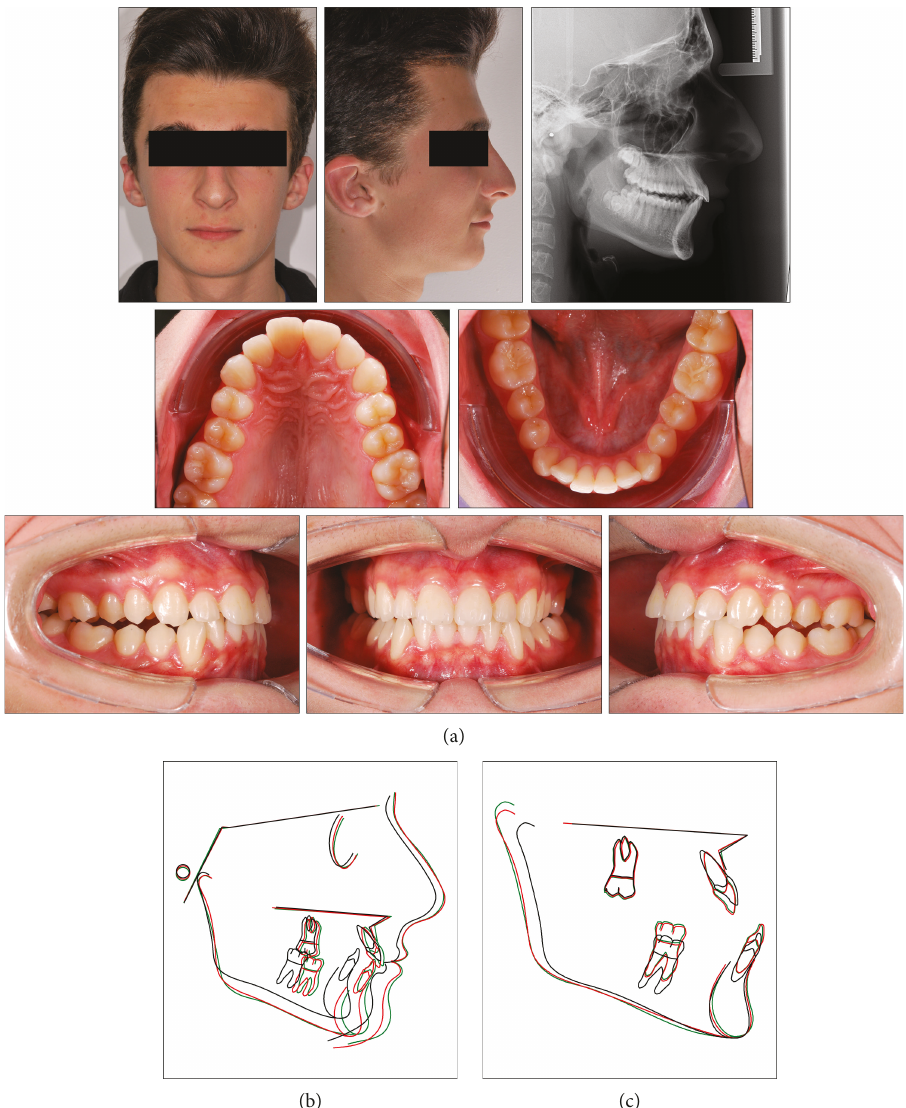
Figure 5: Case 1. (a) Patient after 18 months of follow-up (including 6 months of retention) when he was 15 years and 4 months old. (b) Superimposition of pretreatment (black), posttreatment (red), and follow-up (green) cephalometric tracings on stable structures of the anterior cranial base. (c) Regional superimposition of cephalometric tracings on the maxilla and